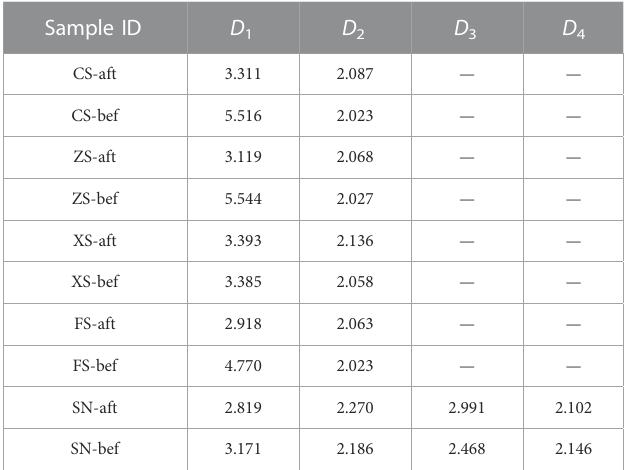
TABLE 1 Fractal dimension calculation